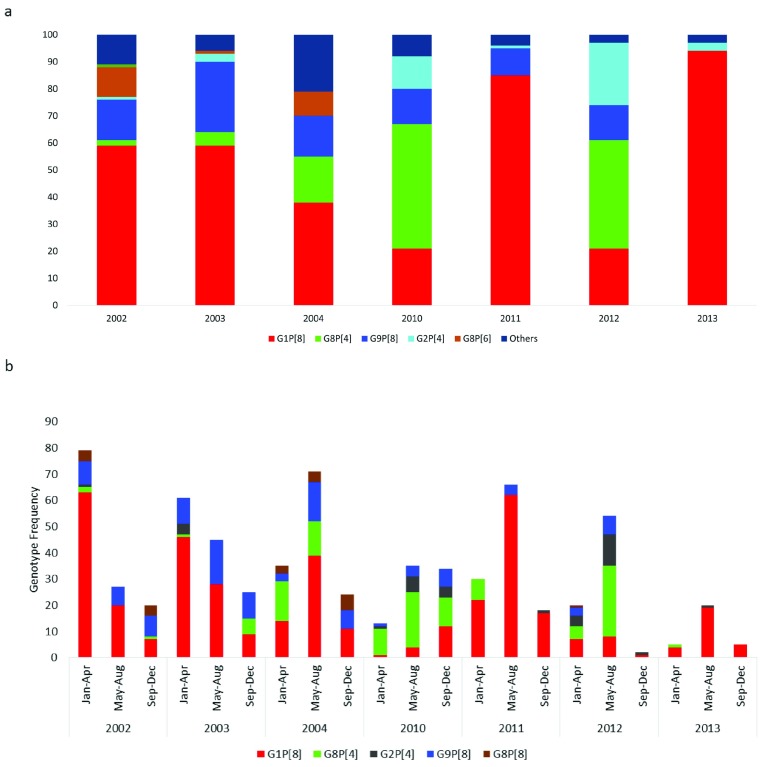
Temporal distribution of RVA genotypes from positive RVA cases isolated from Kilifi County Hospital from 2002–2004 and 2010–2013.(
A) Annual proportions of the common genotypes. (
B) The 4-month frequency of the commonly occurring genotypes. The colors represent the GP combinations as indicated on the legend of the plots. Genotypes that fall in the “Others” category in (
A) represents those that occurred in low frequency <5%: G8P[8,14], G1P[4,6], G9P[4,6], G2P[8], G12P[4,6,8], G3P[4,6], G10P[8].